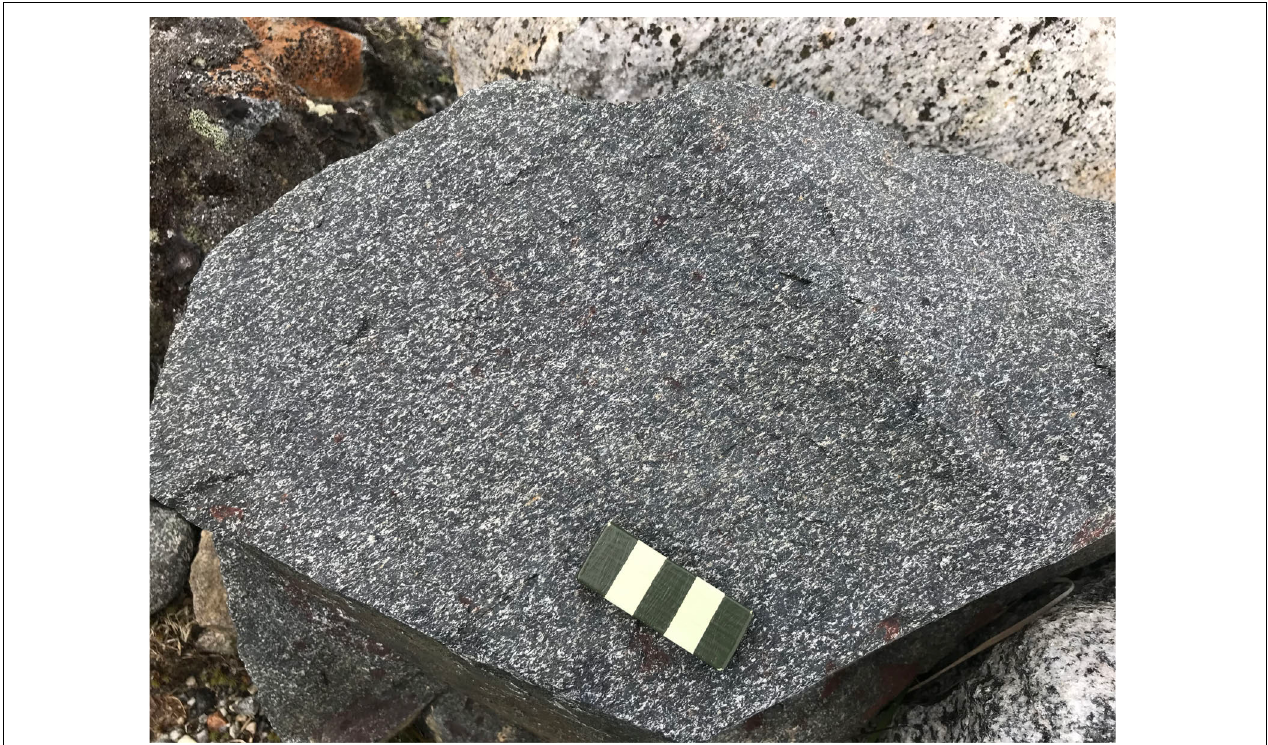
FIGURE 3 | “Film” metatexite, Lammasoaivi, NW Finland, Rommaeno Complex, Norrbotten Province. Fine-grained, weathered quartz-feldspar films of crystallized melt indicate the onset of very low-degree partial melting of amphibolite at low-strain conditions. Length of scale 5 cm.